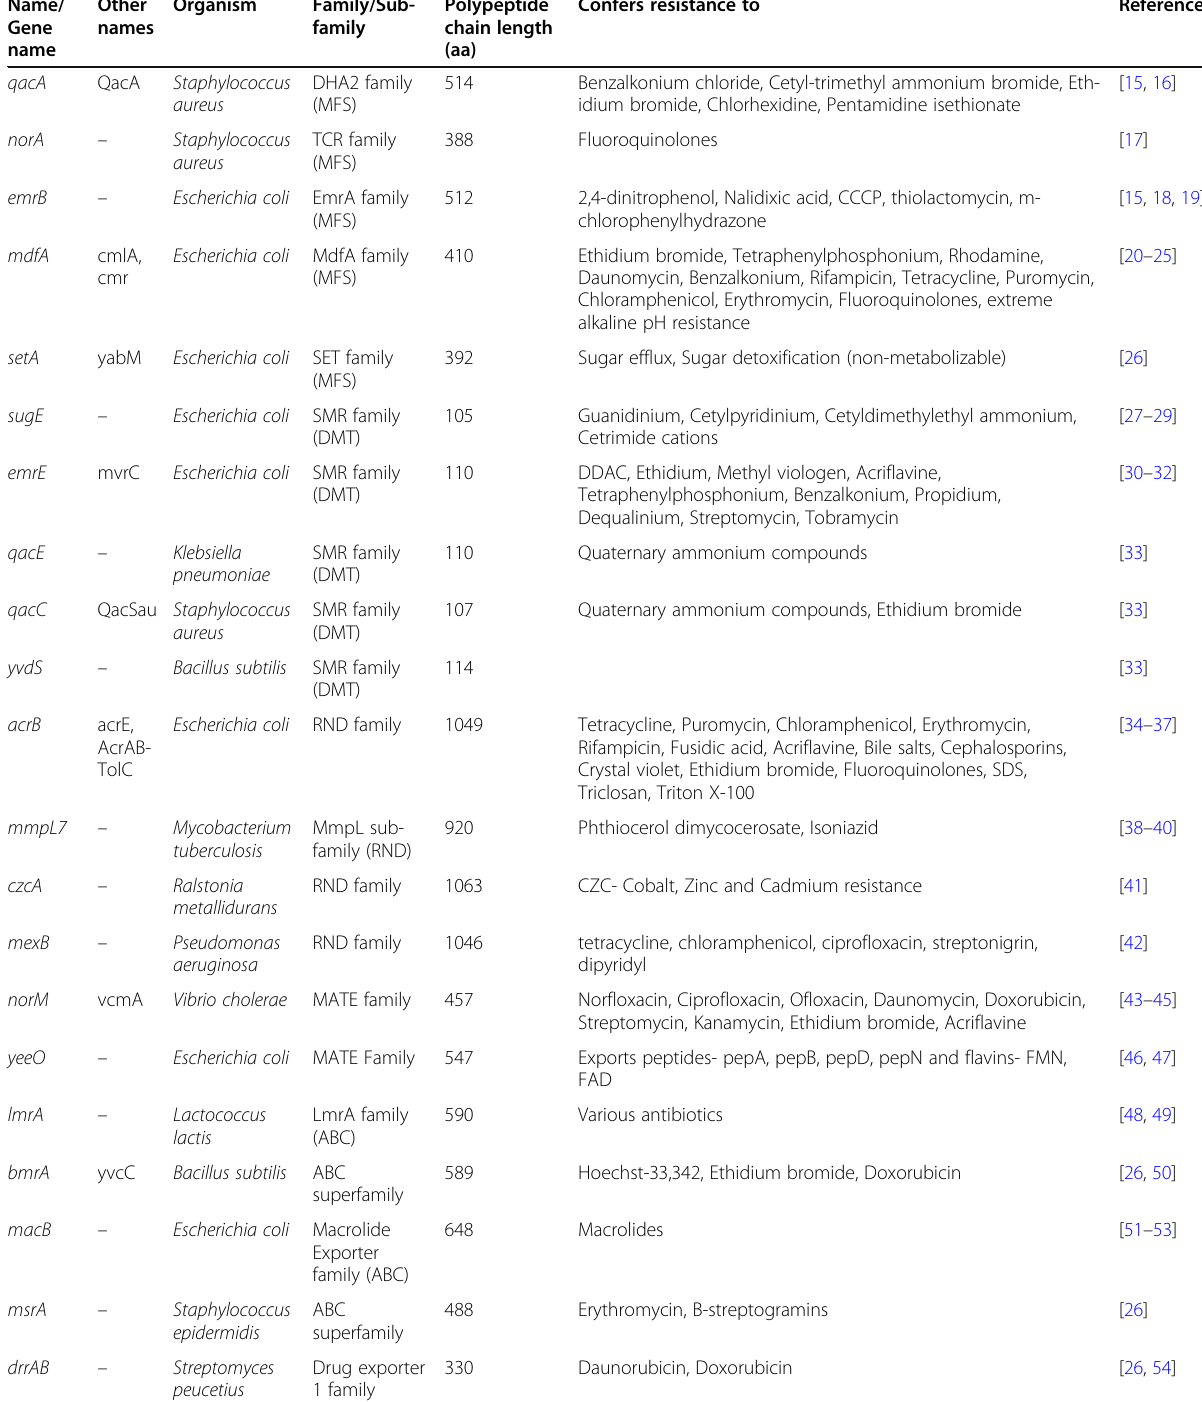
Table 1 Bacterial efflux